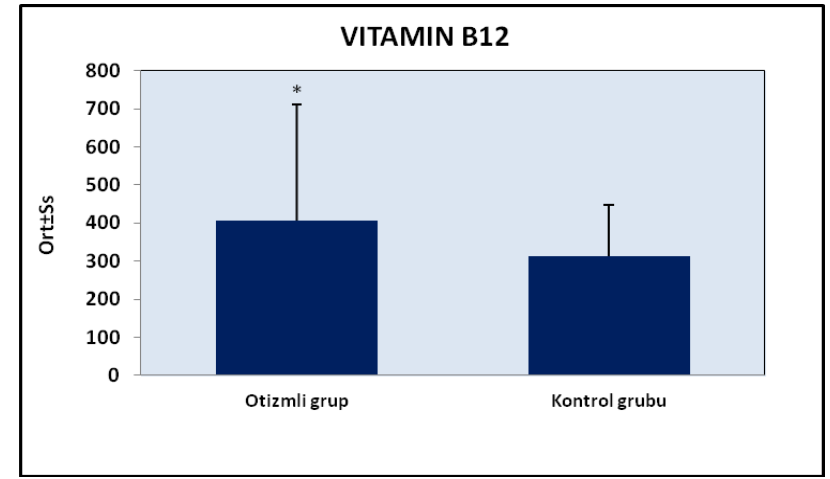
Figure 5. Distribution of Vitamin B12 Measurements by Groups